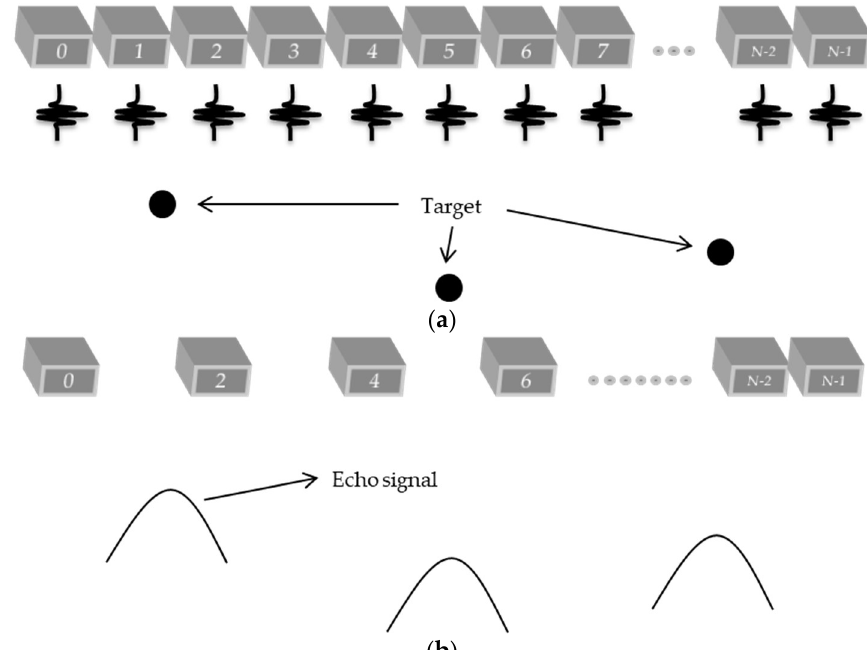
Figure 8. Plane wave with sparse arrays technique: ( a ) Transmission process of the ultrasonic pulse with all of the transducer elements; and ( b ) Reception of the echo signal using only the even elements including the last element (65 active elements).